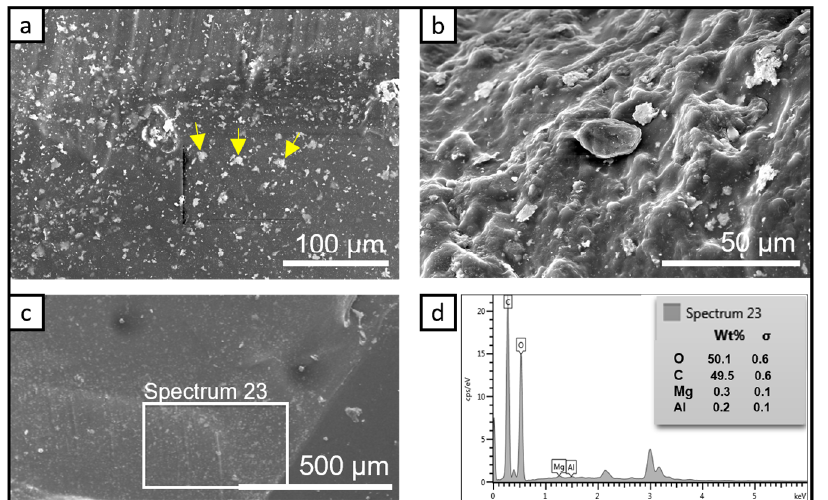
Figure 2. Representative SEM micrographs of bio-PA1010 nanocomposites filled with LDH 5%: low magnification image showing the rough surface of the sample, with LDH aggregates (marked in ( a ) with yellow arrows); detailed view of the LDH aggregates ( b ); the area selected for the EDS analysis ( c ); and the EDS spectrum and elemental composition of the selected area ( d ).